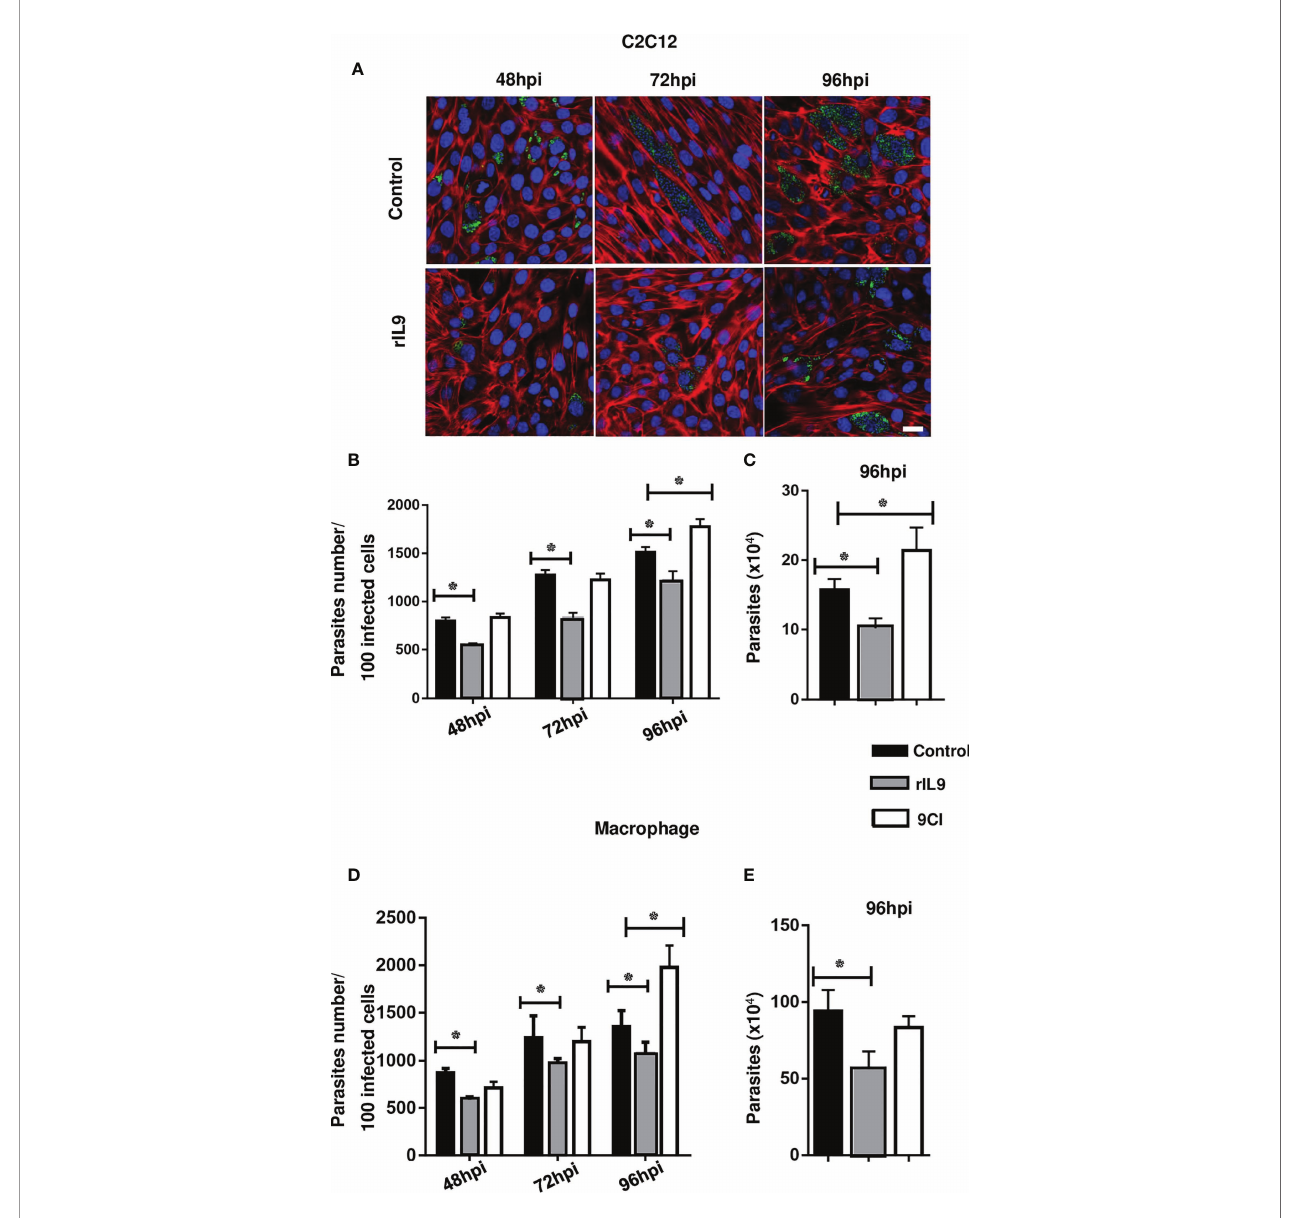
FIGURE 2 | rIL9 treatment decreased intracellular amastigote multiplication in infected C2C12 cells and macrophages, and IL-9 neutralization reversed the effect. Cells were infected with trypomastigotes for 3 h and then treated with rIL9 (25 ng/mL or 10 ng/mL) or 9CI (1.25 µg/mL) for 48 hpi, 72 hpi, and 96 hpi. The following were stained: nucleus (DAPI - blue), actin cytoskeleton (TRITC - red), and parasites (mAb2C2 - Alexa Fluor 488 - green) (A) . Graphs show the number of parasites from 100 infected cells (B, D) . The numbers of parasites released after 96 hpi (infected and post-treatment of cells with rIL9 or 9CI) are shown in (C, E) . Control, cells infected and cultured just in RPMI medium. Anova and Student ’ s t-test *p < 0.01. Bar: 25